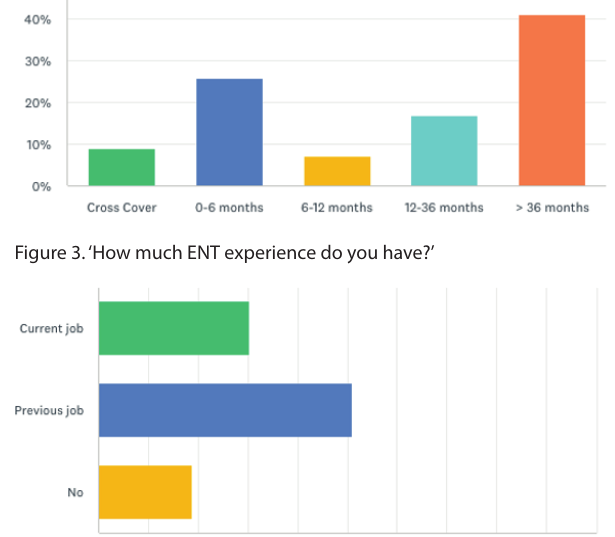
Figure 1. Posterior pack (above), urinary catheter (below).